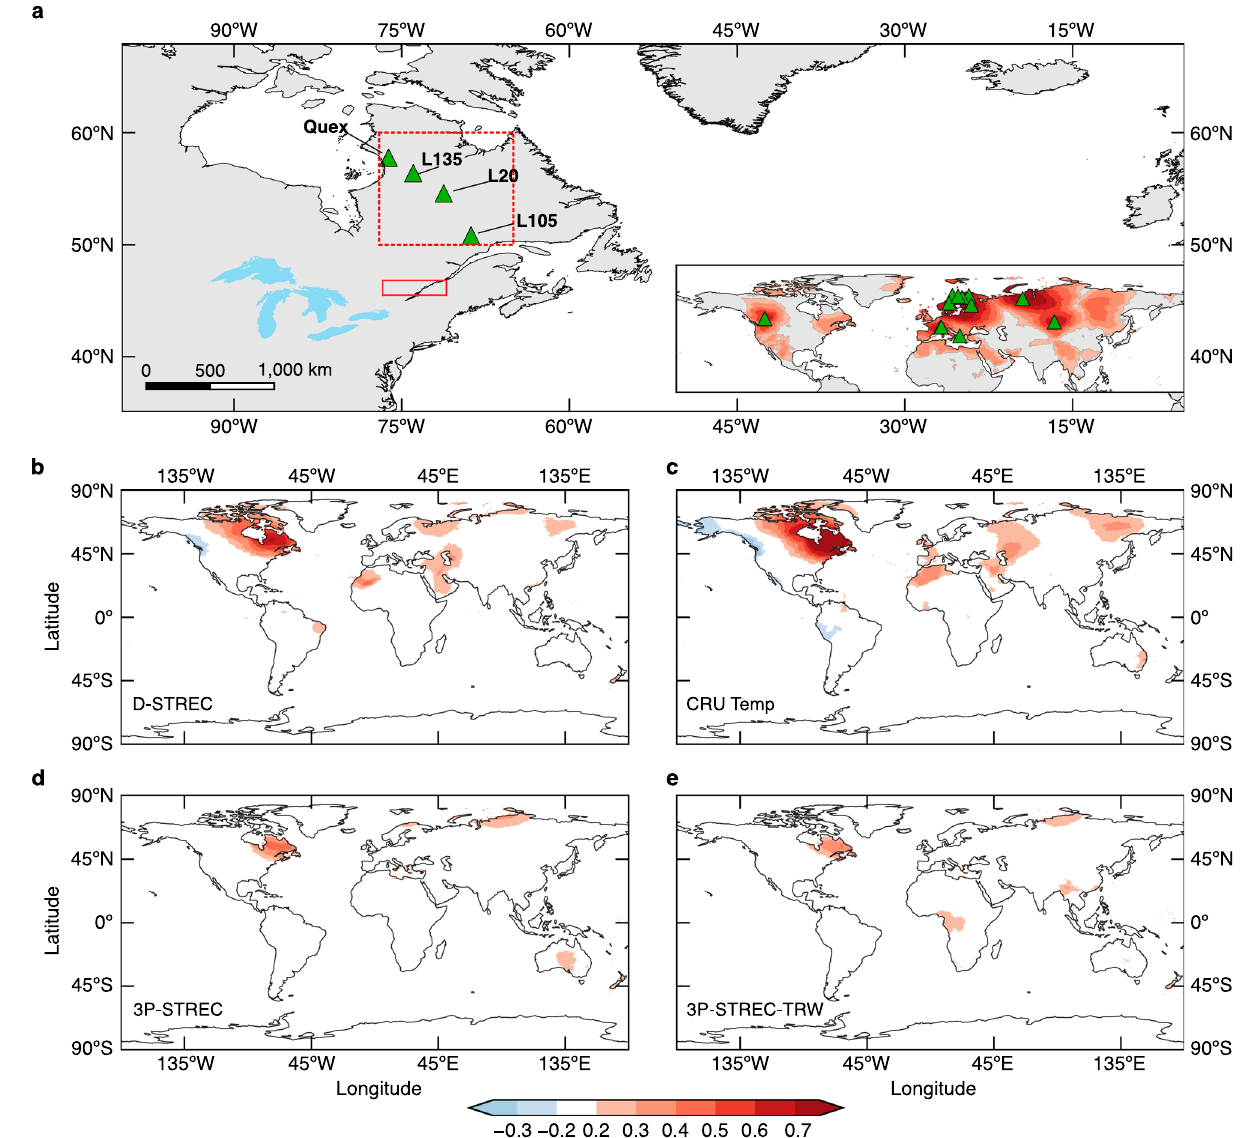
Fig. 1 | Millennial maximum latewood density (MXD) network and correlation fi elds with gridded May – August (MJJA) temperatures of the CRU dataset. a Locations of the MXD network in northeastern North America (NENA) with an inset showing the existing millennial MXD chronologies previously used for sum- mer temperature reconstructions across the Northern Hemisphere (see details in Supplementary Table 1) as well as their correlations with MJJA temperatures over the 1901 – 1976common time interval.The inset mapshows the maximal positive r- values ( P <0.05) across correlation fi elds of individual MXD series, thus indicating the North American data gap. The red dotted square (50° – 60°N, 65° – 77°W) encloses the area used to calculate the regional temperature target from the CRU